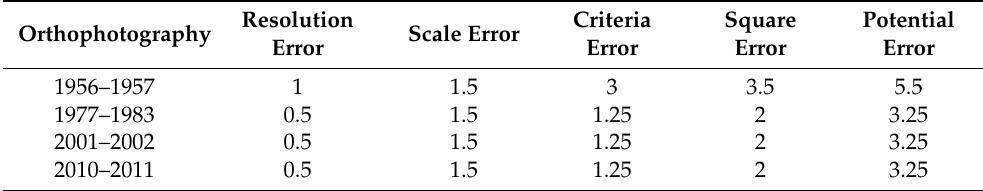
Table 2. Square and potential error (m) for each study period.